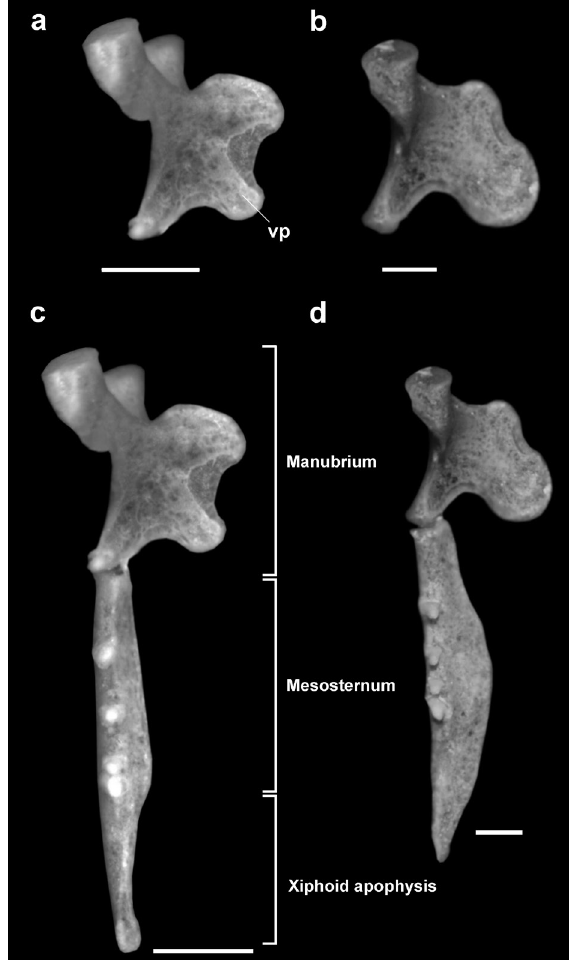
Figure 9 - Lateral view of sternum: a, c . Micronycteris microtis ; b, d : Sturnira erythromos . Acronyms: vp: ventral process. Scale bar represents 1 mm.